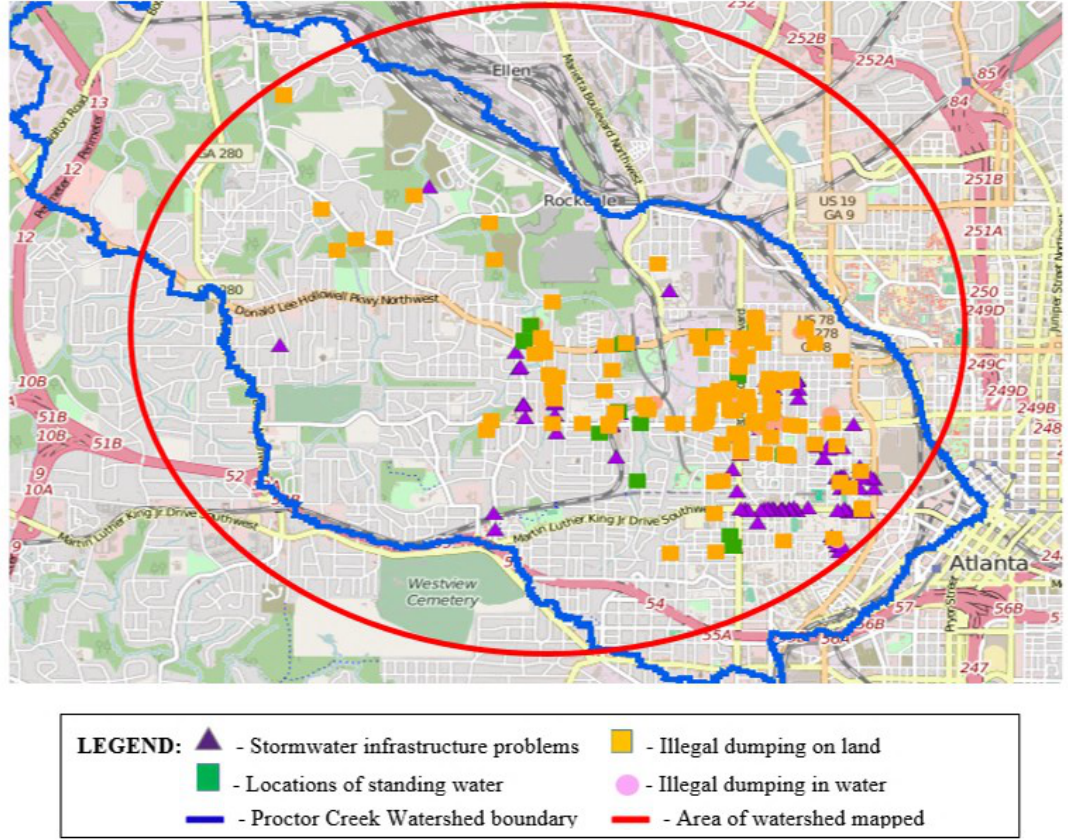
Figure 2. Community-generated map of Proctor Creek Hidden